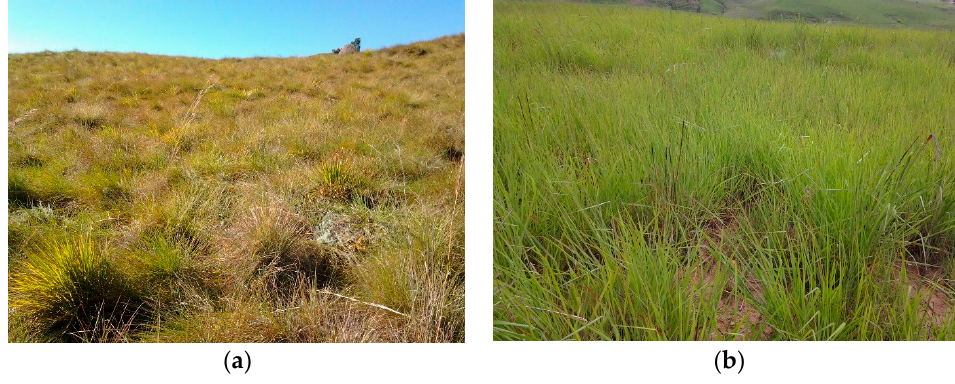
Figure 2. F. costata ( a ) and T. triandra ( b ) dominated landscapes (February 2016).